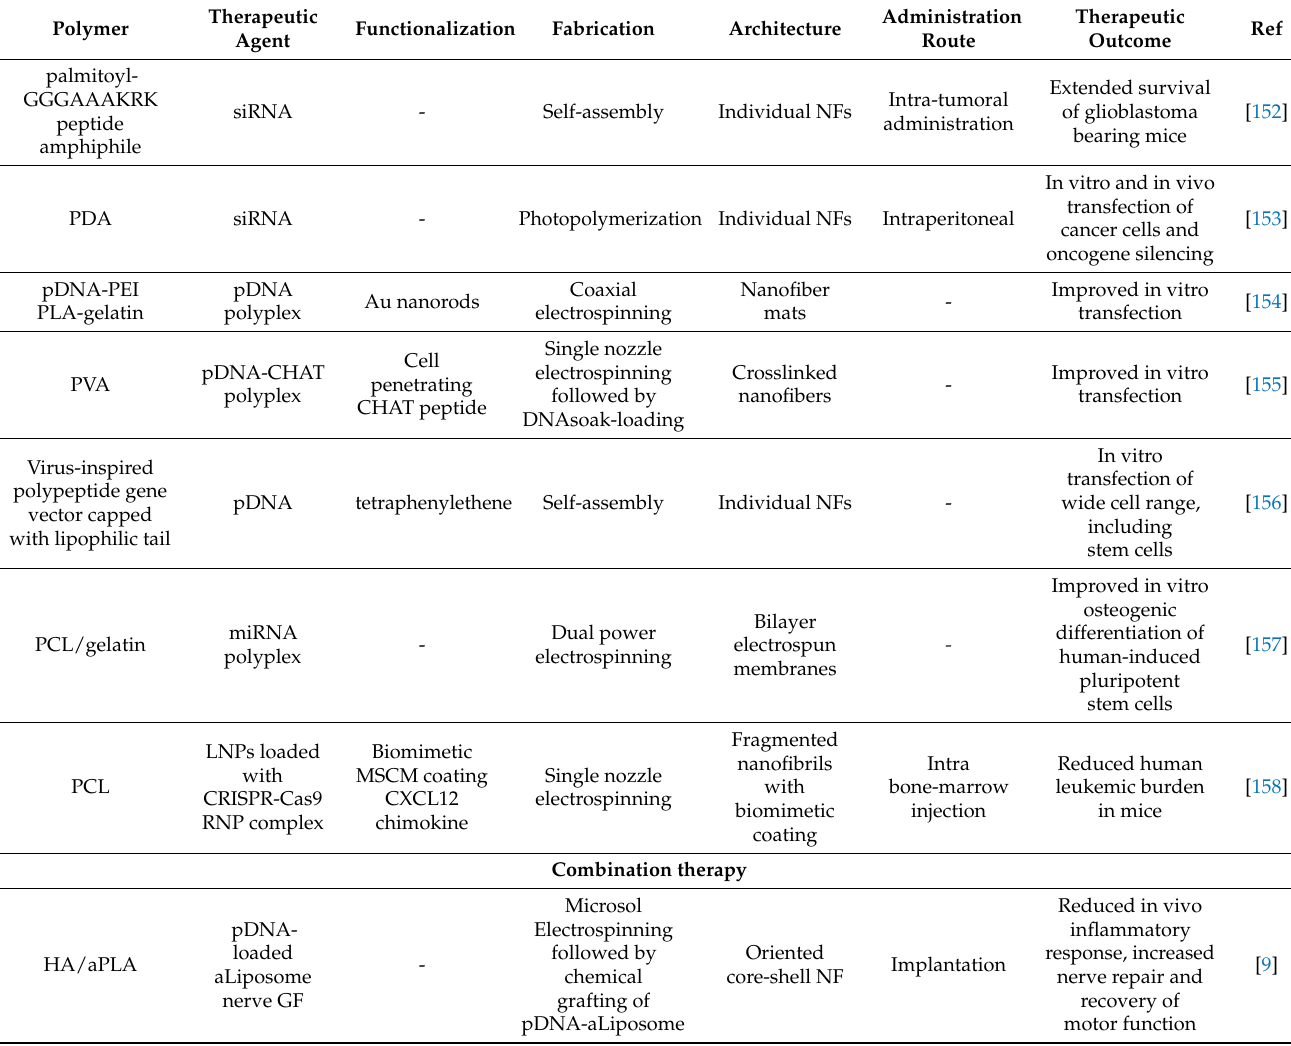
Table 4. Nanofiber systems used for the delivery of